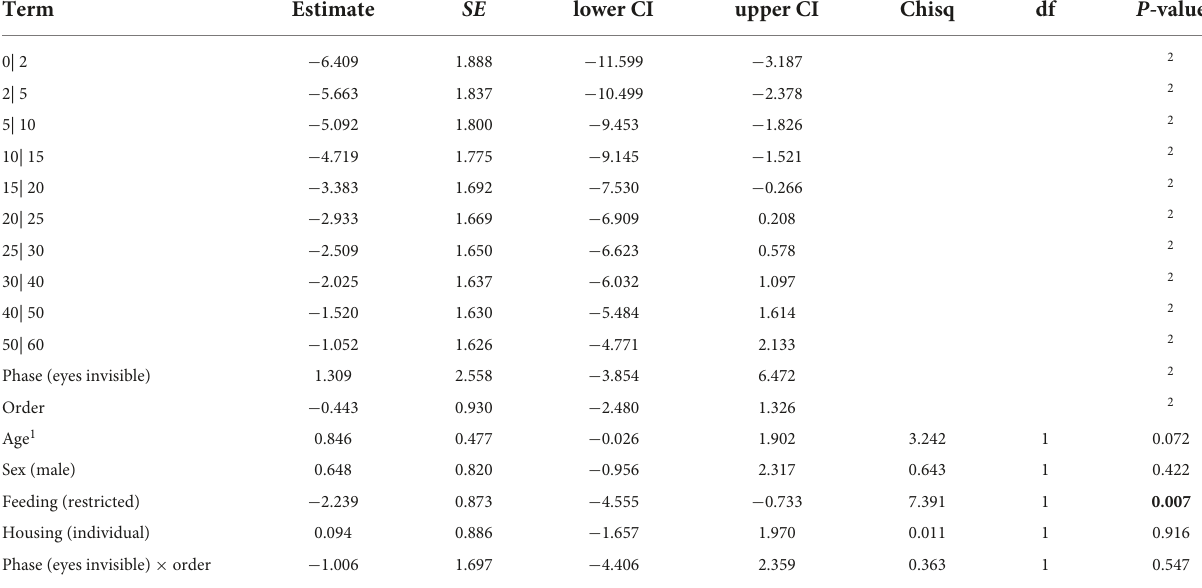
TABLE 2 Effects of predictors on maximum delay duration based on CLMM with horse and experimenter as random effects (full model). Term Estimate SE lower CI